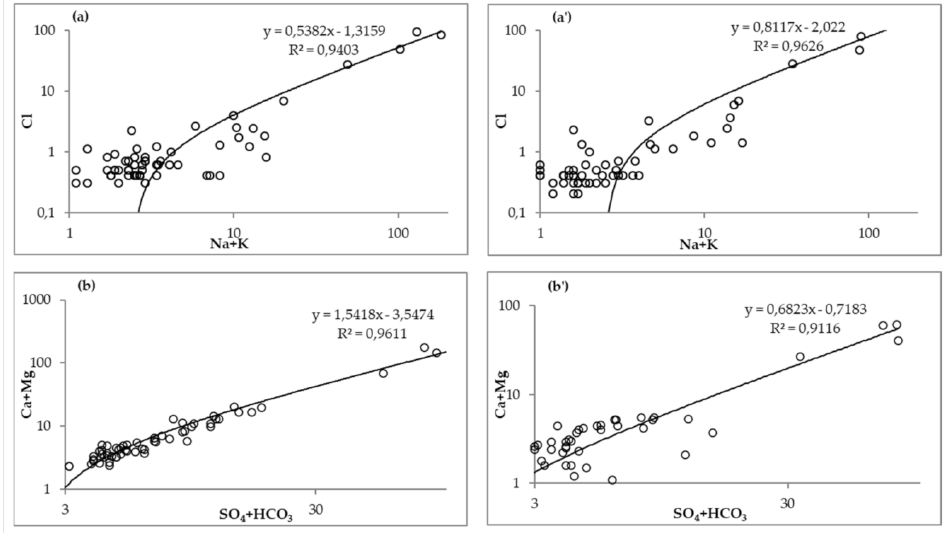
Figure 8. Bivariate plots Na+K vs. Cl ( a )—pre-vegetation, ( a’ )—post-vegetation Ca+Mg vs. SO 4 +HCO 3 ( b )—pre-vegetation, ( b’